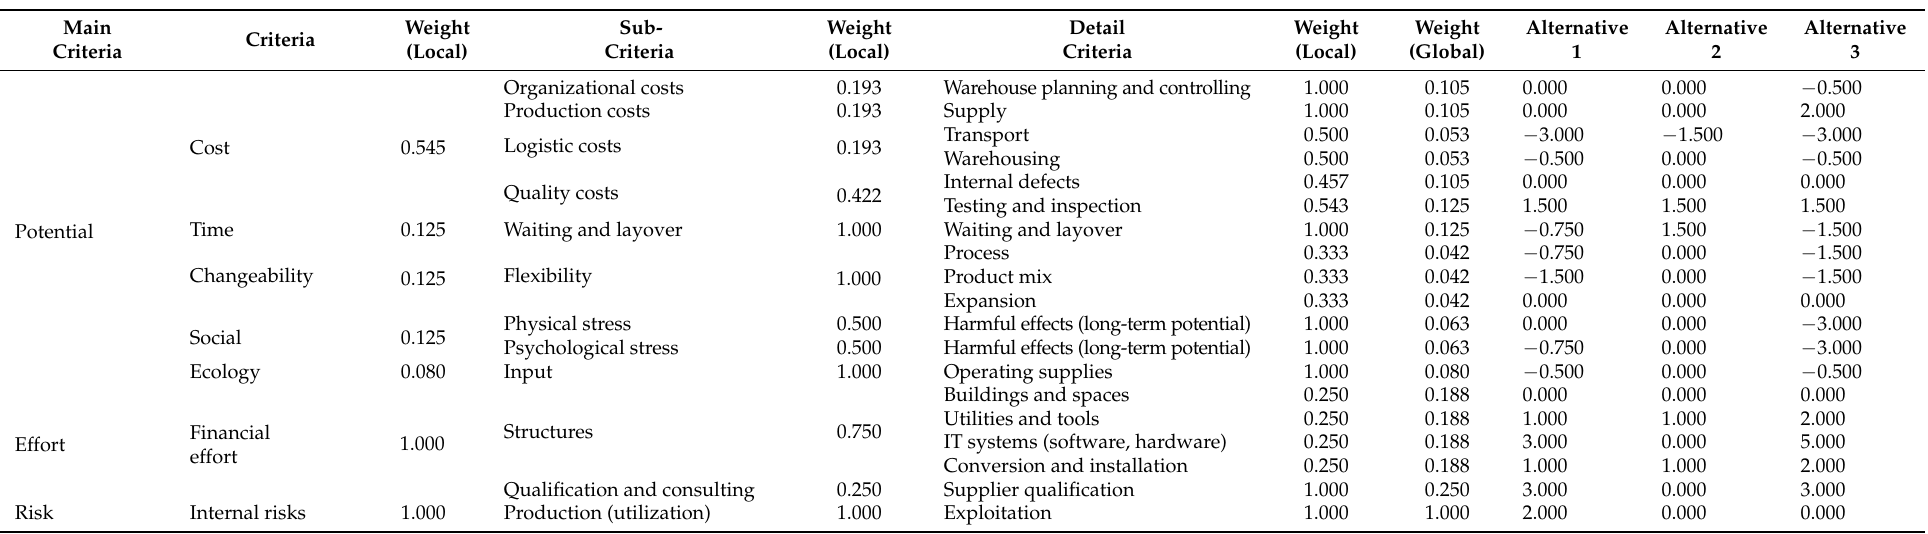
Table 4. Use case application: criteria and